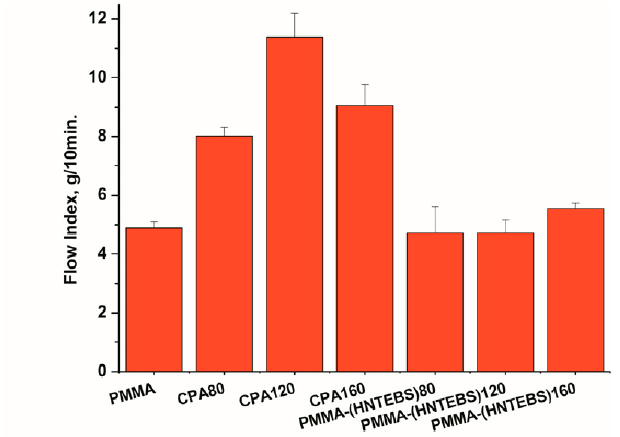
Figure 15. Improvements of PMMA melt flowability by the presence of HNT decorated with EBS at different temperature (80, 120, 160 °C for both masterbatches-CPA and final PMMA nanocomposites).